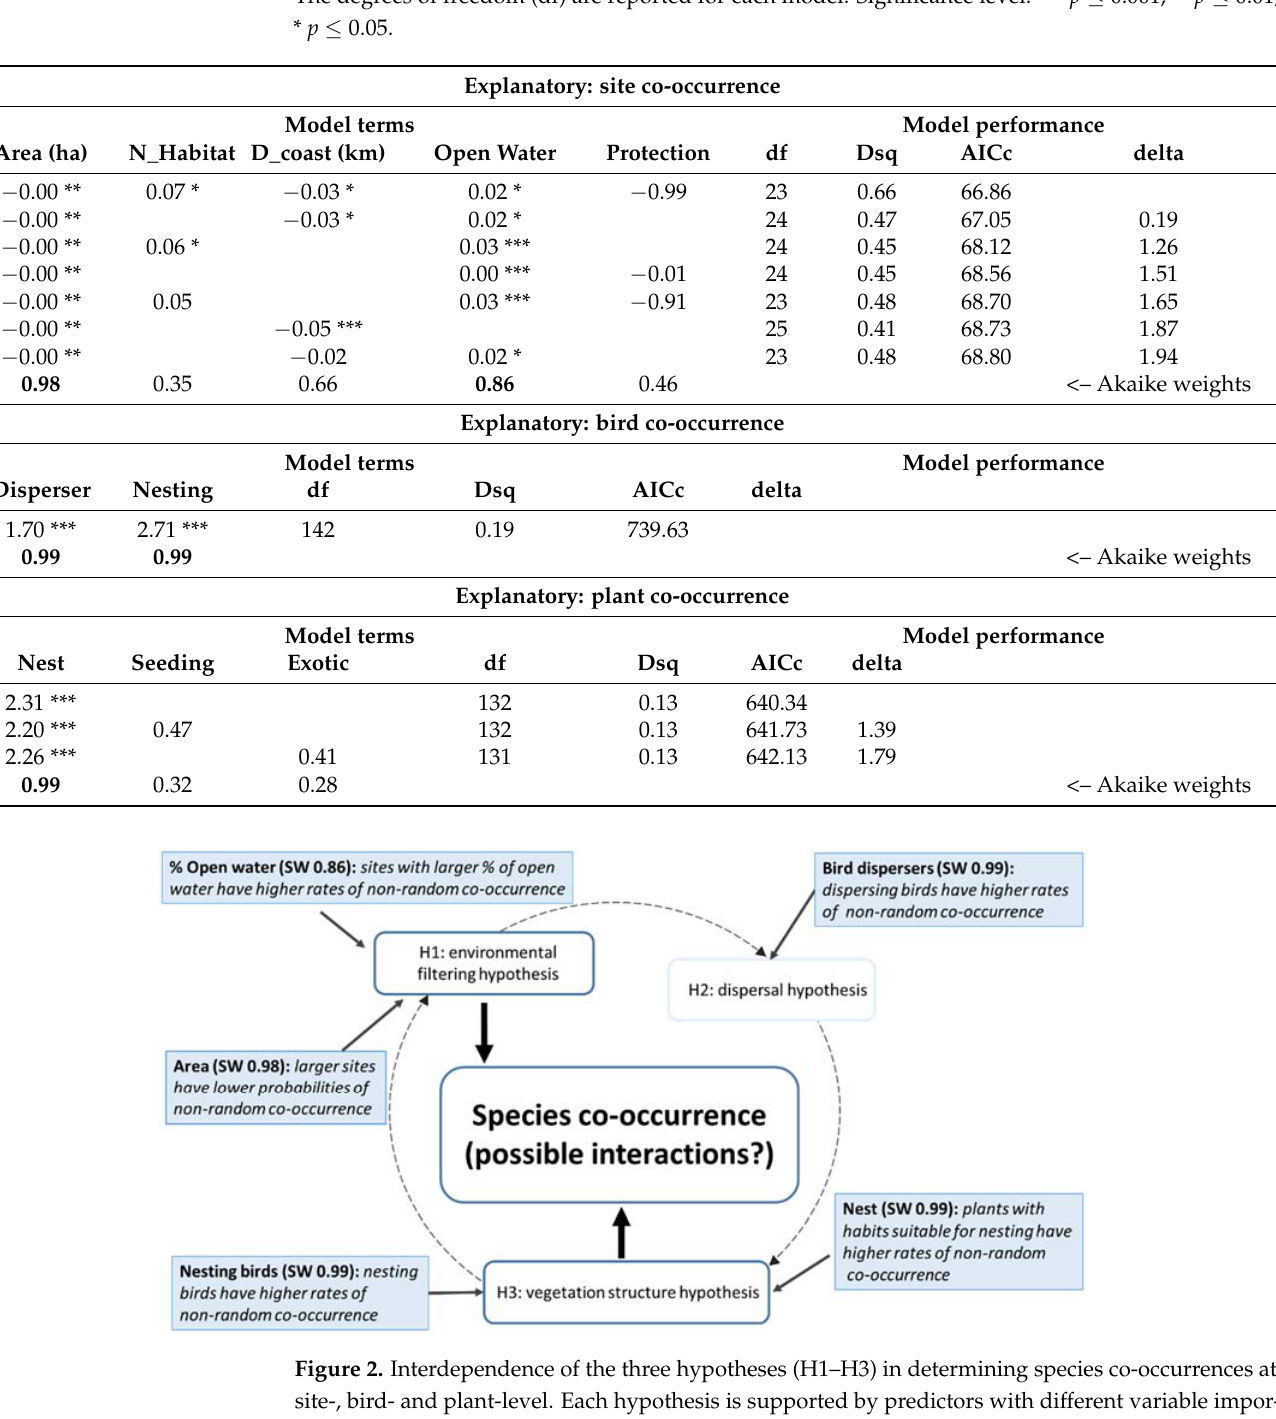
Table 1. GLM models and information for site-, bird- and plant-based co-occurrence. Best GLMs (all models within ∆ AICc ≤ 2) are shown. Predictor traits not present in the model are indicated by NA. See Materials and Methods for explanation of model terms. Adjusted D-squared (D 2 ) was reported in addition to the Akaike information criterion corrected for small sample sizes (AICc). Note that the variable importance, in terms of sum of Akaike weights, was calculated for all possible models. The degrees of freedom (df) are reported for each model. Significance level: *** p ≤ 0.001, ** p ≤ 0.01, * p ≤ 0.05.